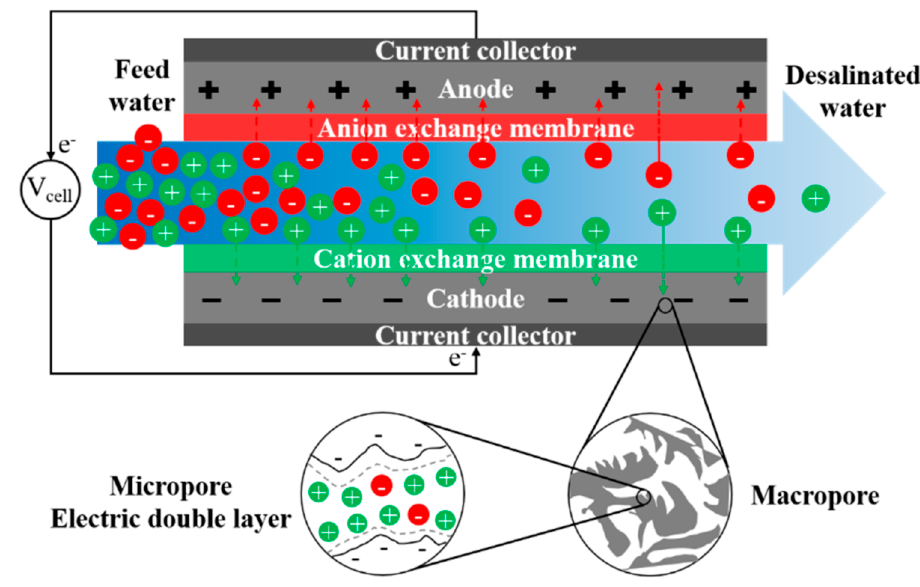
Figure 11. Schematic illustration of membrane capacitive deionization (MCDI) process